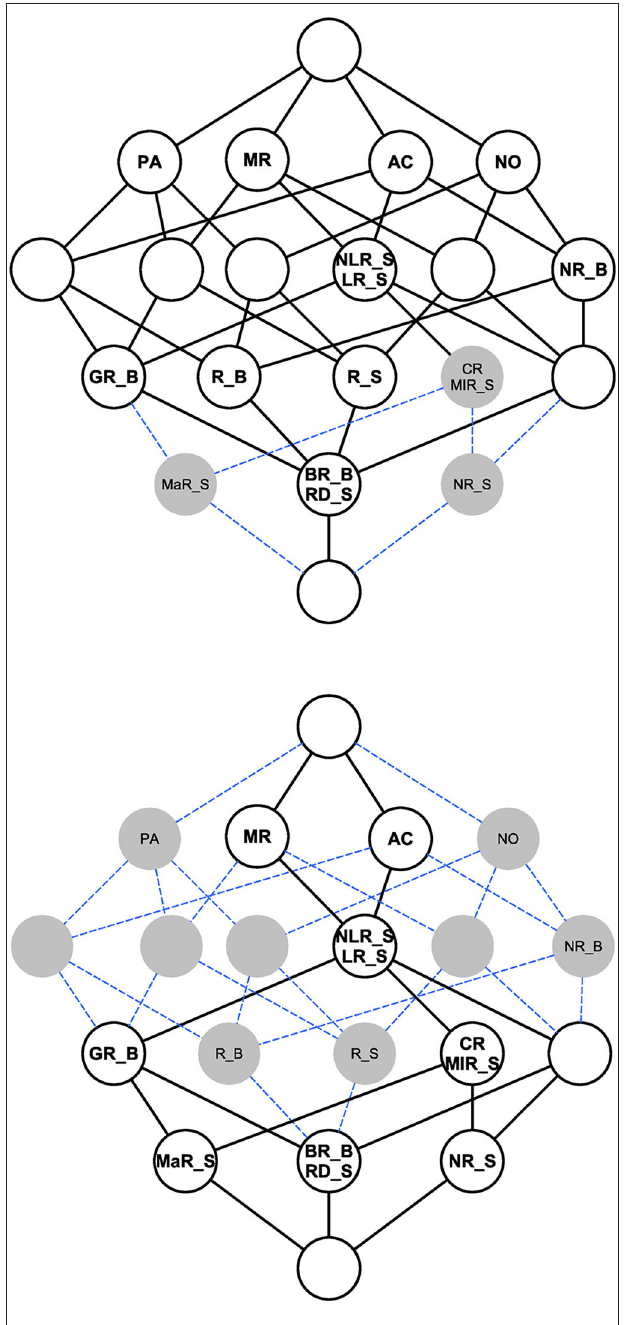
FIGURE 2 | Reduced representation (see text) of the expressions/classes lattice. (Top) Part of the lattice linked with the CBD “biological resource” expression (label BR_B); (bottom) Part of the lattice linked with the UNCLOS “living resource” expression (label LR_S). Labels combine the final B (from “biodiversity”) for CBD or S (from “sea”) for UNCLOS (sea) and the following sub-labels: GR, genetic resource; MaR, marine resource; MiR, mineral resource; NLR, non-living resource; NR, natural resource; R, resource; RD, resource deposit. Generic ontological classes are “actor” (AC label), “material resource” (MR label), “cognitive resource” (CR label), “process or activity” (PA label), and “norm” (NO label). Grey nodes and blue dashed links do not belong to the sub-lattice (but to the overall lattice) (figures built with the free software Concept Explorer 1.2;